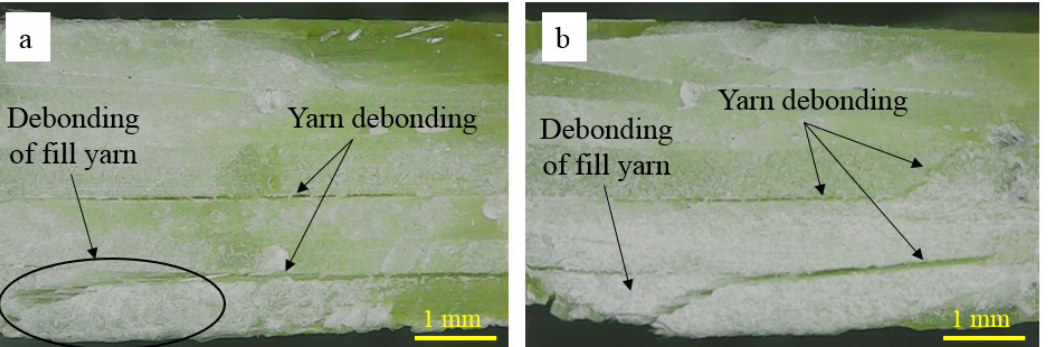
Figure 11. Interlaminar failure in off-axis specimens under flexure load. ( a ) Thermoplastic 3D-FRC and ( b ) thermoset 3D-FRC.